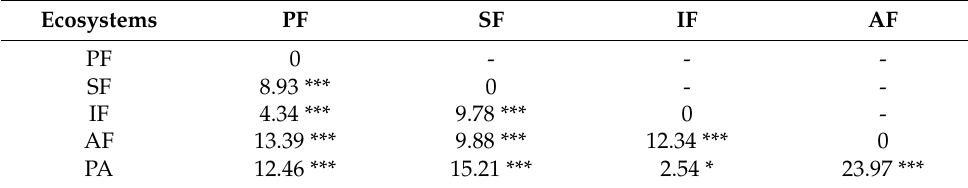
Table 1. PERMANOVA results (based on Bray–Curtis similarity) comparing the composition of high-level diversity richness (HLDr) assemblages between the ecosystems (F = 38.14, p < 0.0001). Ecosystems PF SF IF AF PF 0 - - - SF 9.37 *** 0 - - IF 7.32 *** 11.88 *** 0 - AF 14.39 *** 12.39 *** 14.80 *** 0 PA 18.16 *** 17.51 *** 15.67 *** 7.96 ***